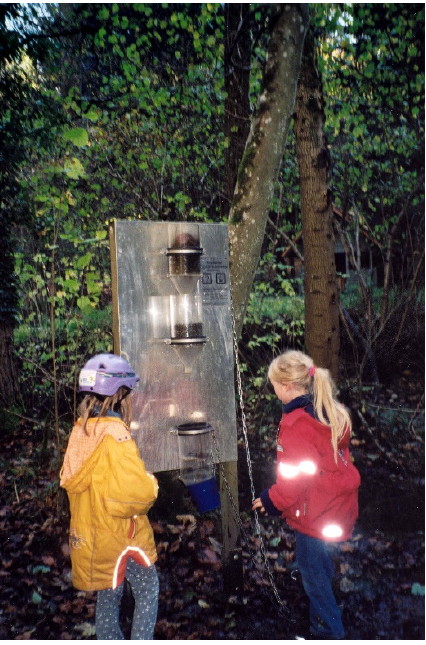
Figure 6. Nature experience trail with interactive station. Stockach Spring Experience Trail (Germany) (Megerle 2001).